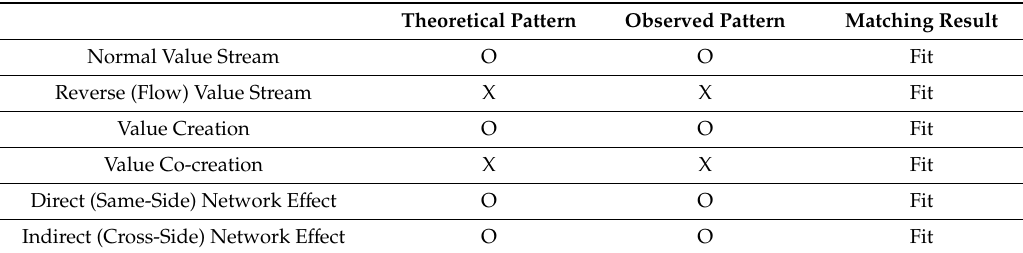
Table 2. First type of platform business model pattern matching.